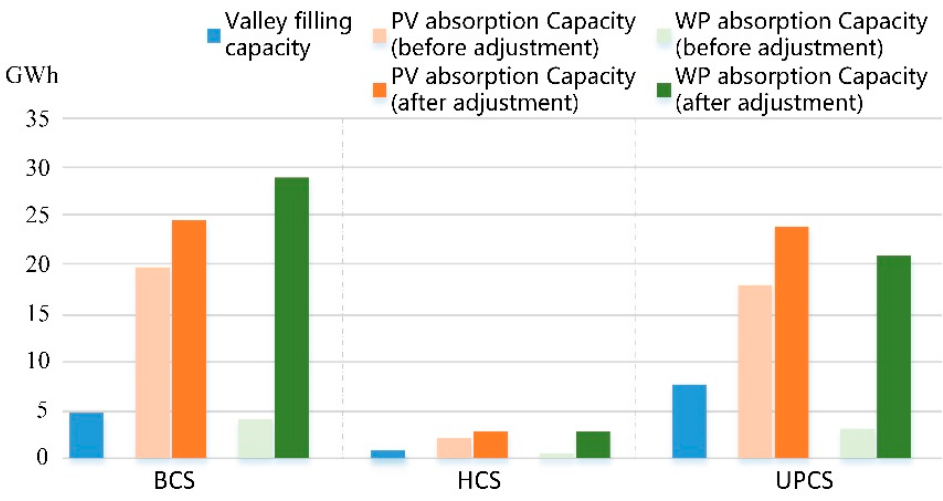
Figure 12. V2G capability of different types of charging stations.